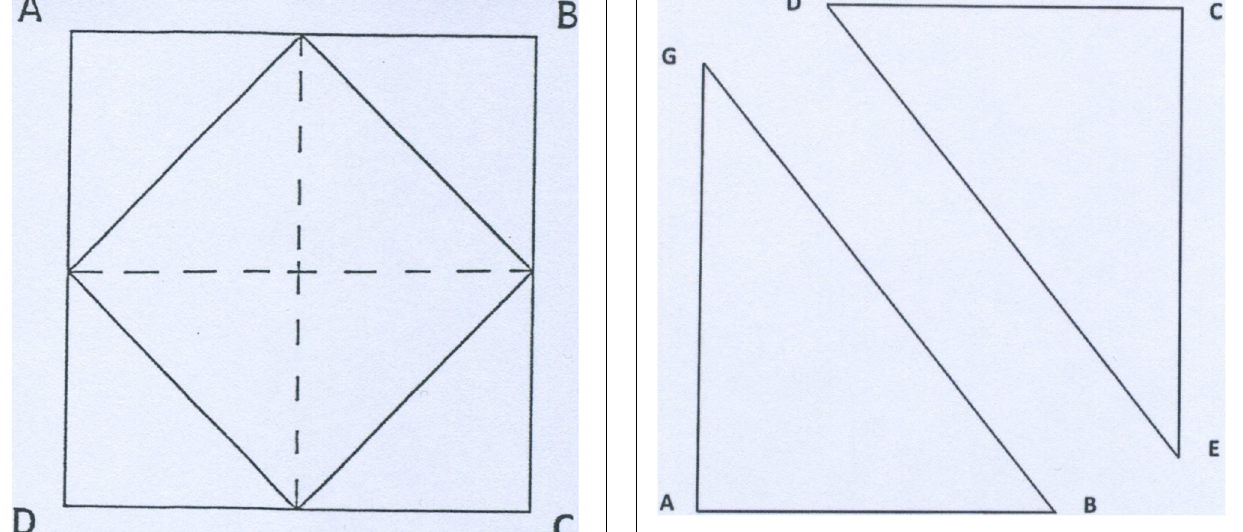
FIGURE 2 | The inverted version.